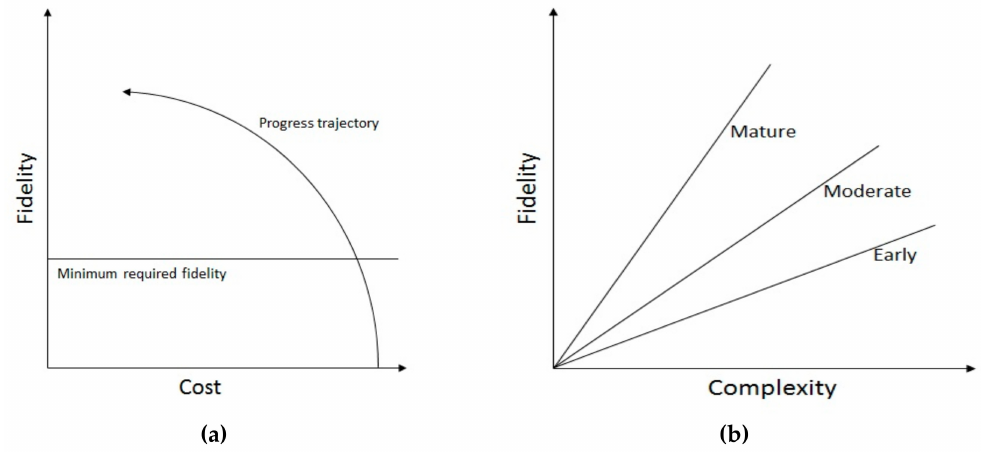
Figure 2. ( a ) Schematic representation of the relationship between fidelity with cost; ( b ) Schematic representation of fidelity vs complexity.